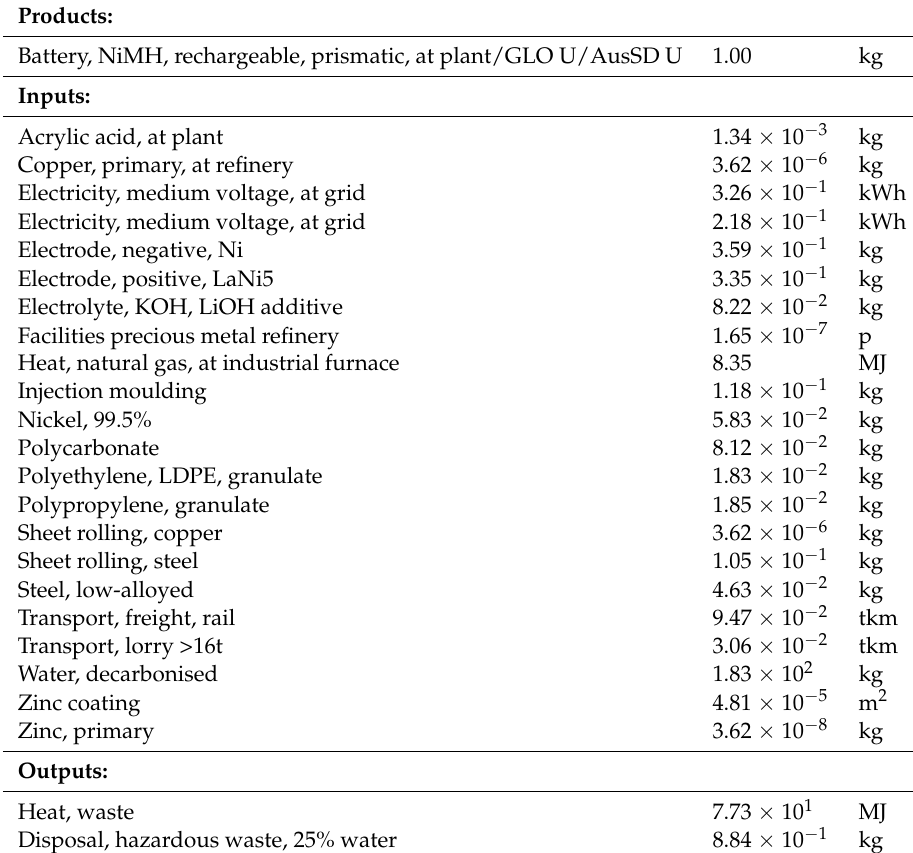
Table 4. life cycle inventory of NiMH battery developed for LCA analysis in this research.